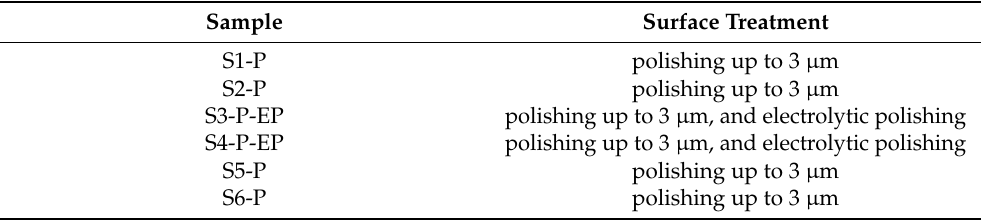
Table 2. List of secondary samples treated by grinding and polishing of primary